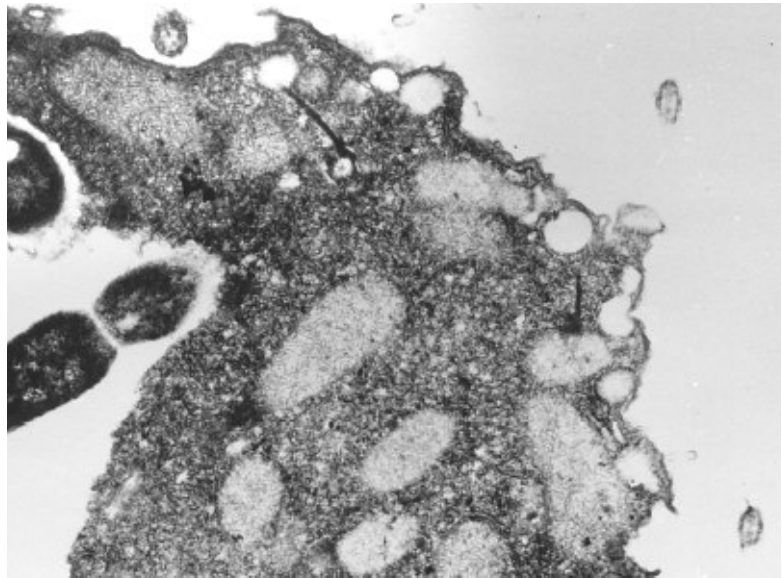
Figure 3. Illustration of the oral region of Tetrahymena pyriformis during ingestion as taken by electron micrograph technique